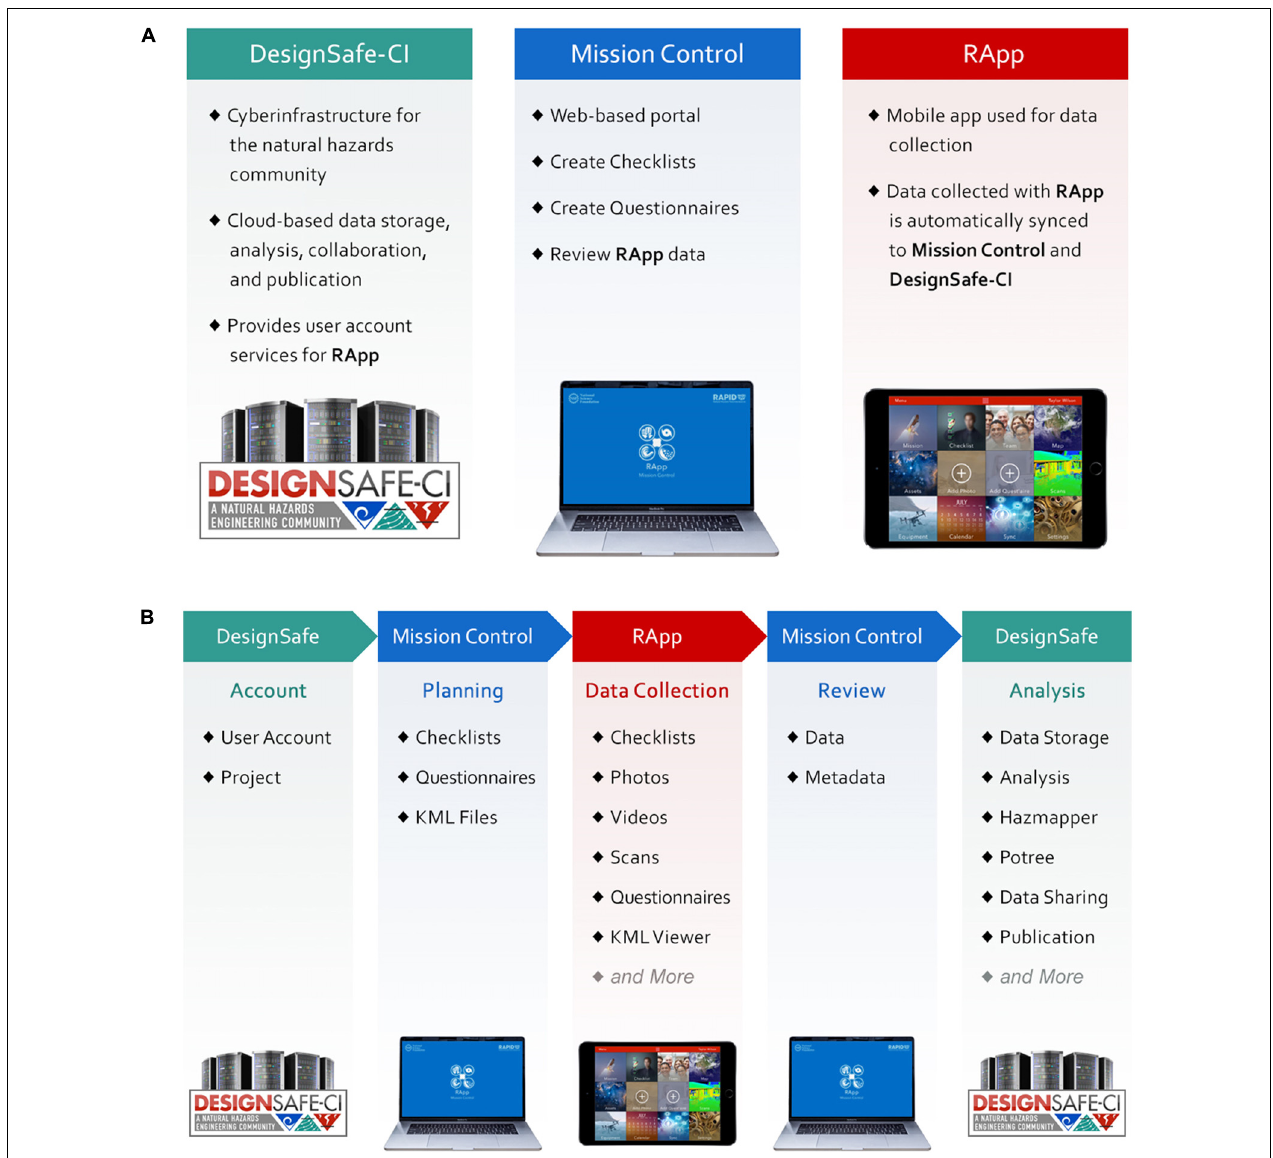
FIGURE 3 | DesignSafe, Mission Control, and RApp: (A) general purposes of each and (B) the field reconnaissance